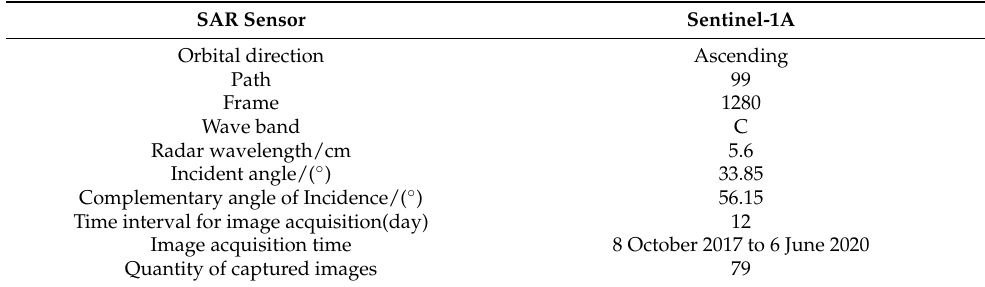
Table 1. The basic parameters of SAR image data.